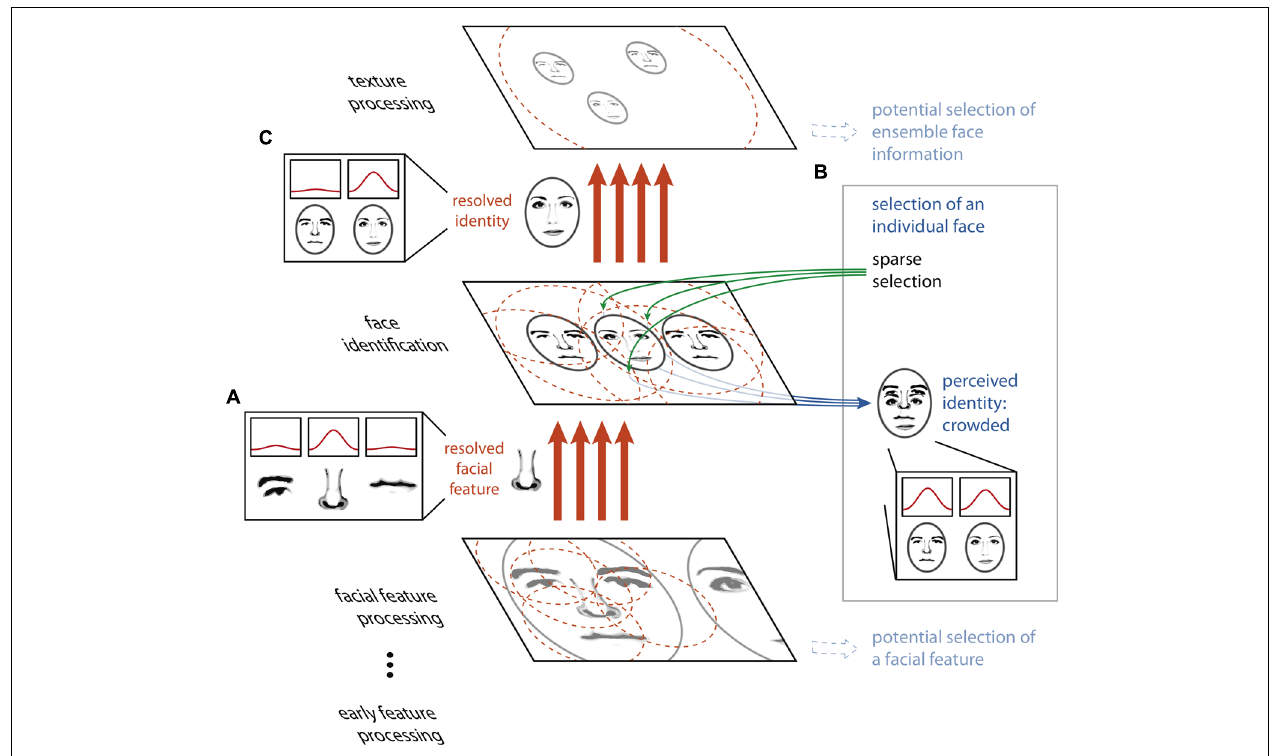
relies on a sparse selection of a subset of the receptive fields or connections from that particular map only, resulting in the read-out of an ambiguous conscious percept (B) . Thus, an object that is perceptually crowded can nonetheless be passed, intact, to a subsequent texture processing stage (C)